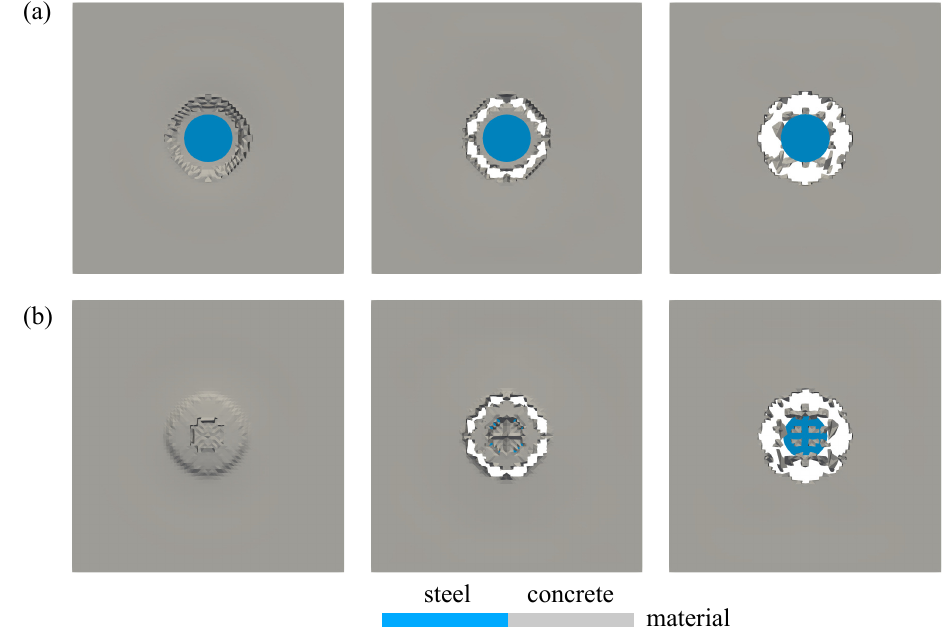
Figure 24. Crack growth visualisation of thin plate impact test: ( a ) top and ( b ) bottom view.